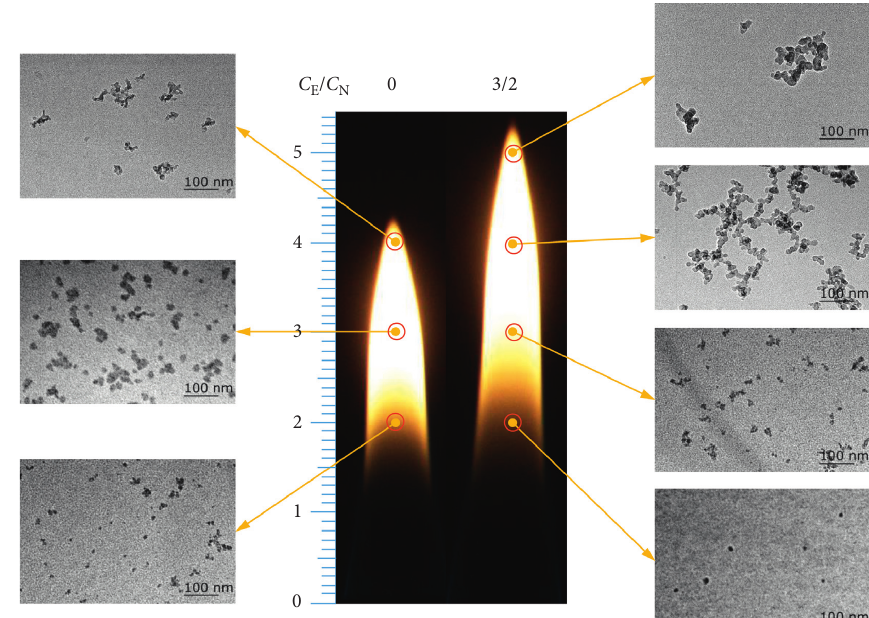
Figure 4: Comparison of soot morphology evolution of pure n- heptane and C